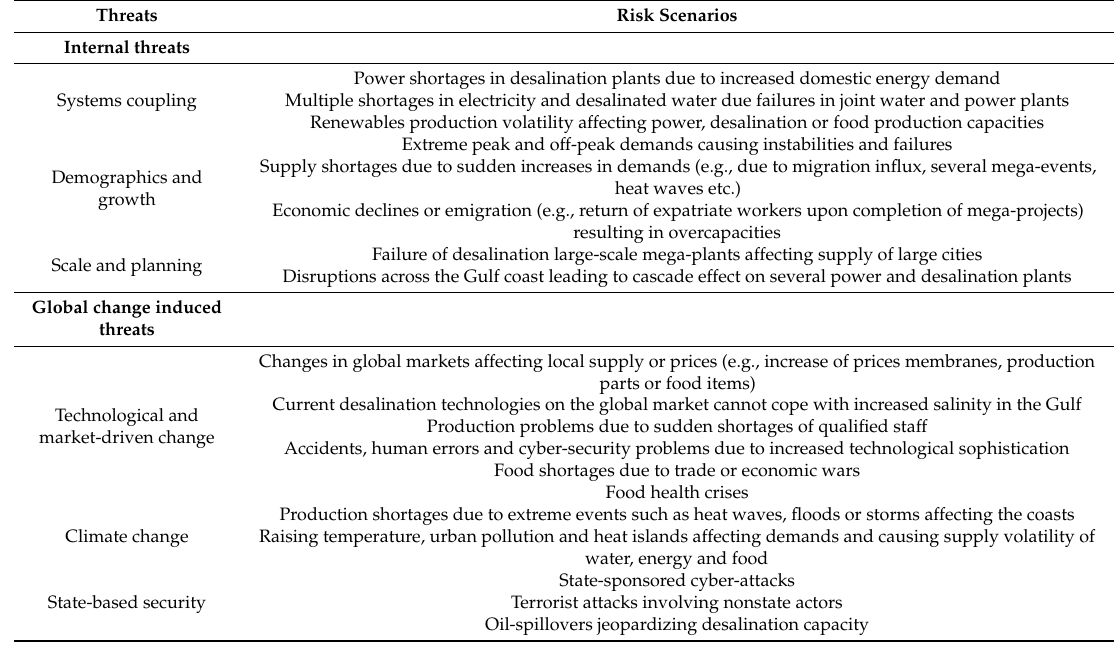
Table 4. Examples of risk